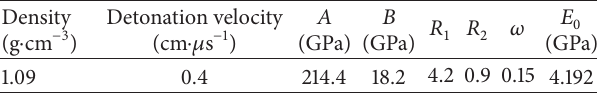
Table 2: Parameters of the